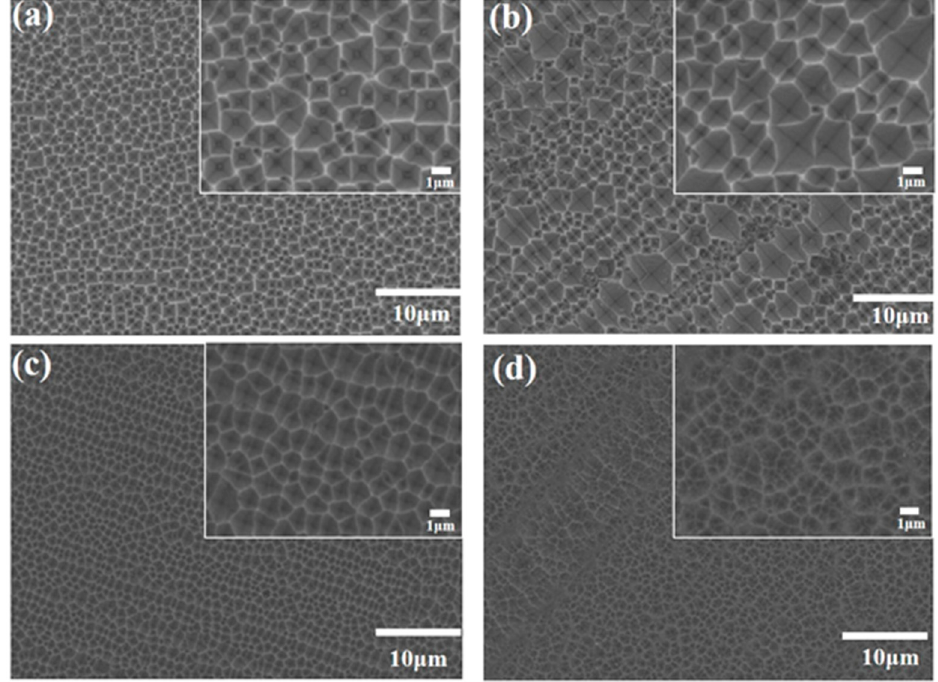
Figure 6. SEM image of the Si surface etched in 0.875 M NH 4 HF 2 Ag@PVP–ACE solution with different H 2 O 2 concentration: ( a ) 0.3 M; ( b ) 0.6 M; ( c ) 1.2 M; ( d ) 1.5 M. All above samples were etched at 65 °C for 20 min.